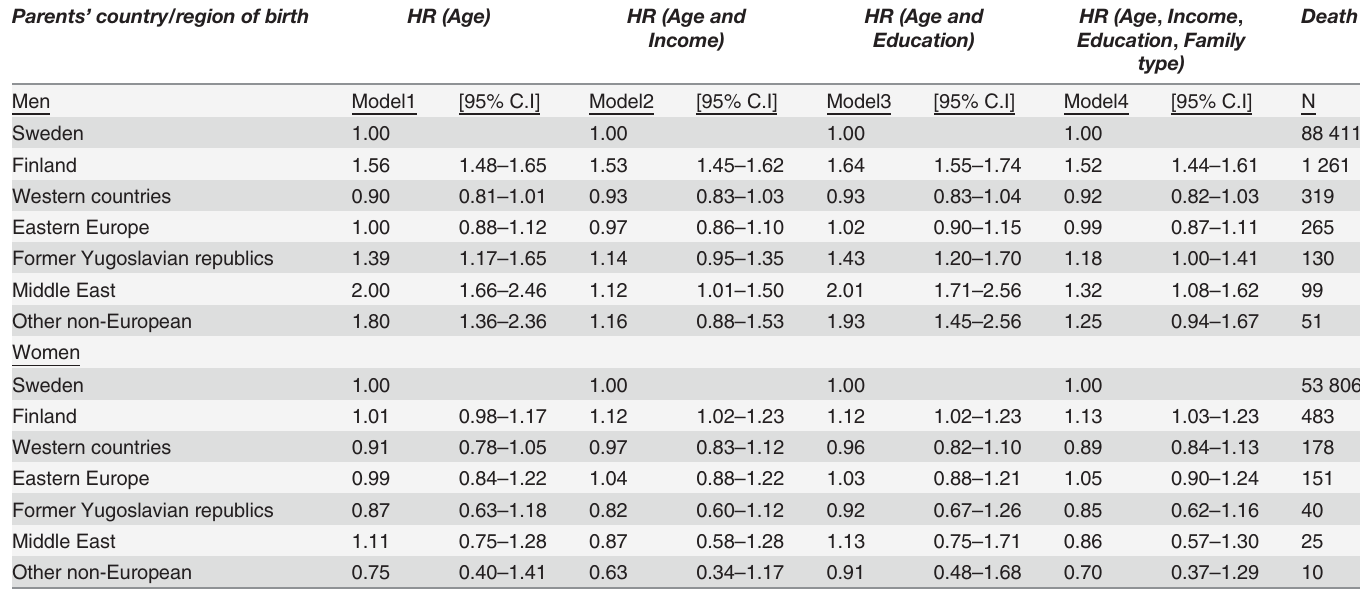
Table 3. Hazard ratios (HR) of all-cause mortality in offspring of immigrants in Sweden, 1990 – 2008. Parents ’ country/region of